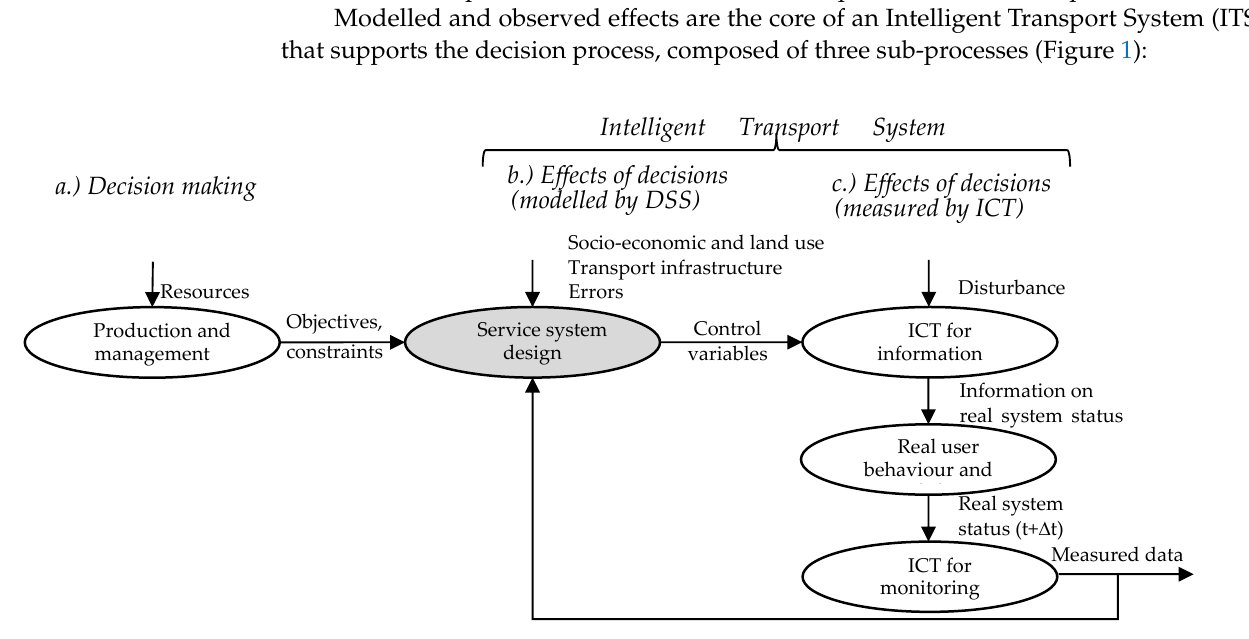
Figure 1. The framework to support S-MaaS policies definition.